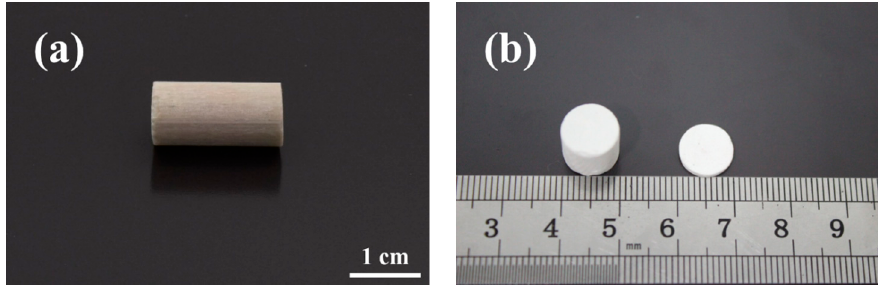
Figure 2. Digital photos of porous PLA scaffolds for P 80-20 : ( a ) before porogen leaching and ( b ) after machining and porogen leaching.